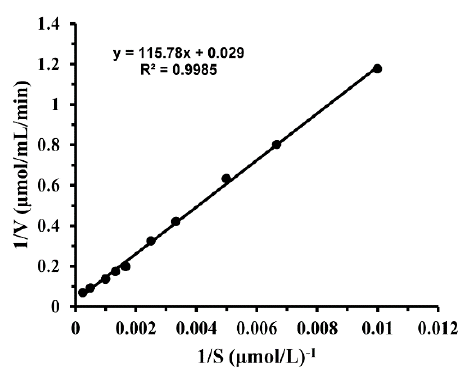
Figure 4. Lineweaver–Burk plot of recombinant GSJ. Table 2. Kinetic parameter of recombinant GSJ.